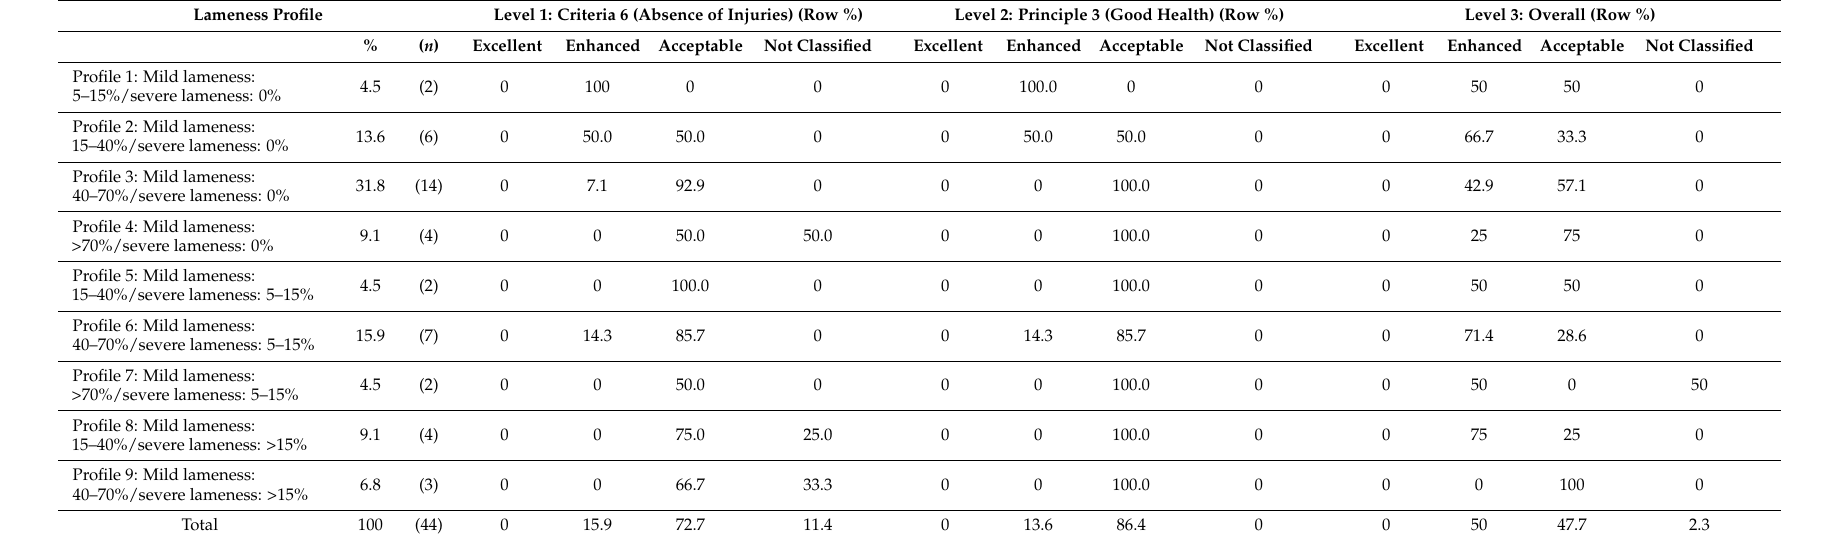
Table 2. The 44 dairy cattle farms profiled according to lameness (in prevalence of mild and severe lameness), and share of the profiled farms that are assigned as excellent, enhanced, acceptable, and not classified at the criteria, principle and overall assessment.